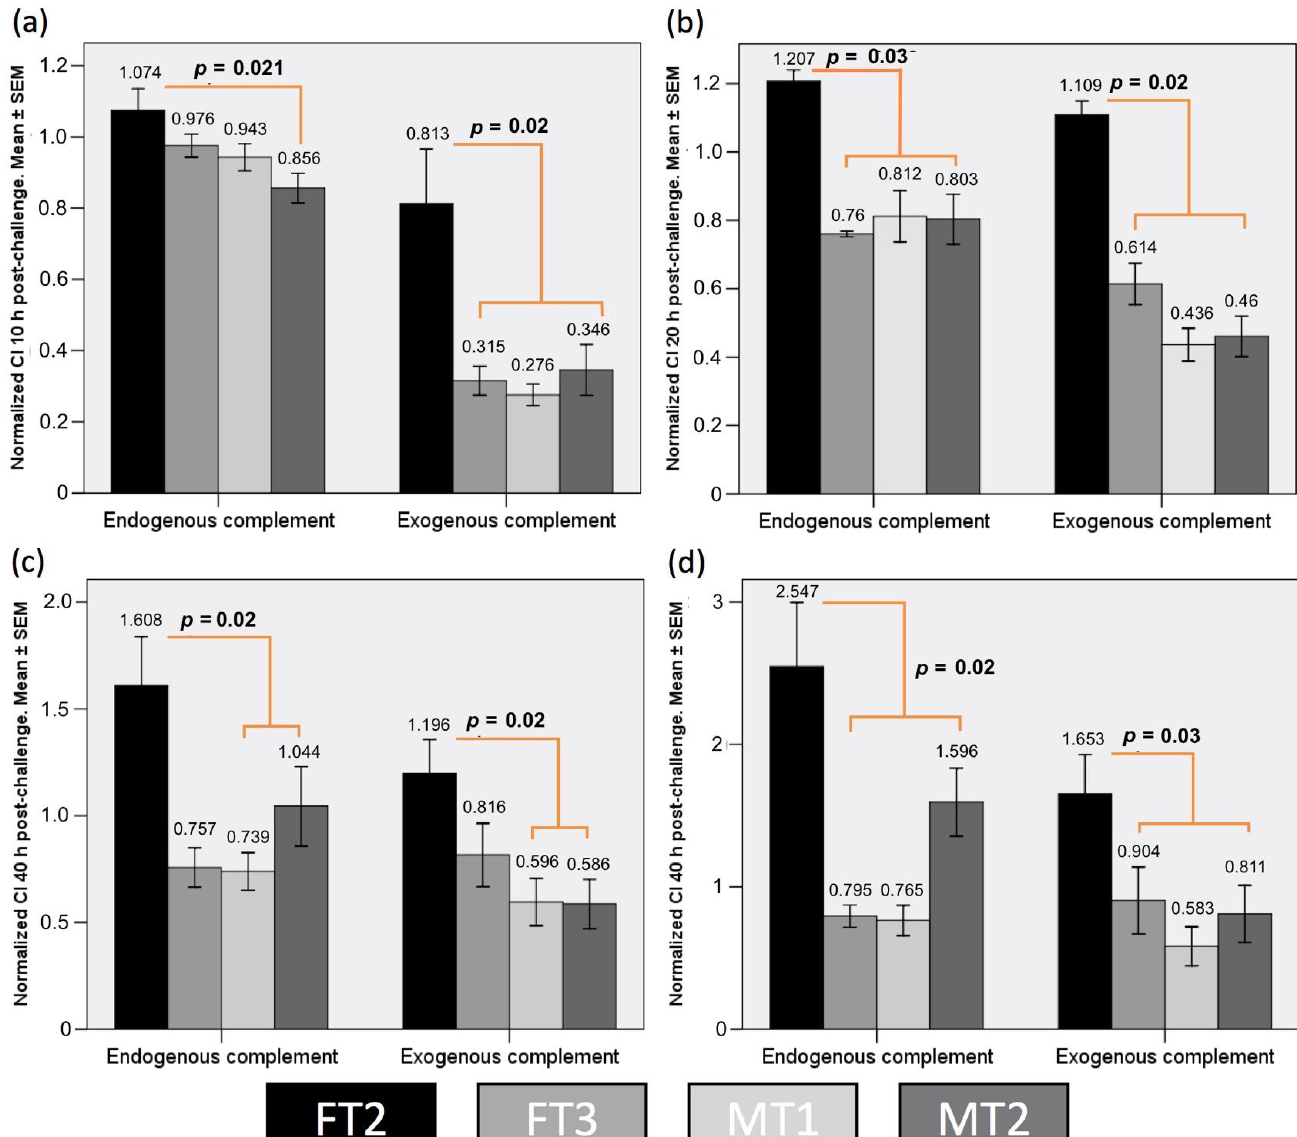
Figure 5. Normalized CI for each specimen’s fibroblast and for endogenous and exogenous complement groups at (a) 10 h, (b) 20 h, (c) 30 h and (d) 40 h post-challenge. Results are shown as mean ± standard error of the mean (SEM) of triplicate measurements.